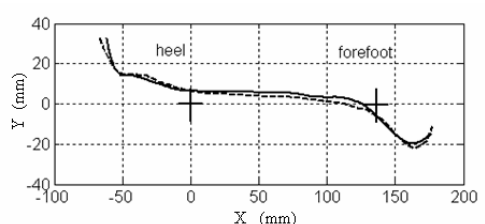
Fig. 3. Center of pressure (CoP) measured by wearable sensor systems (solid line) and force plate (dashed line) expressed in global coordinates system. The center of each force sensor is indicated by the black cross.